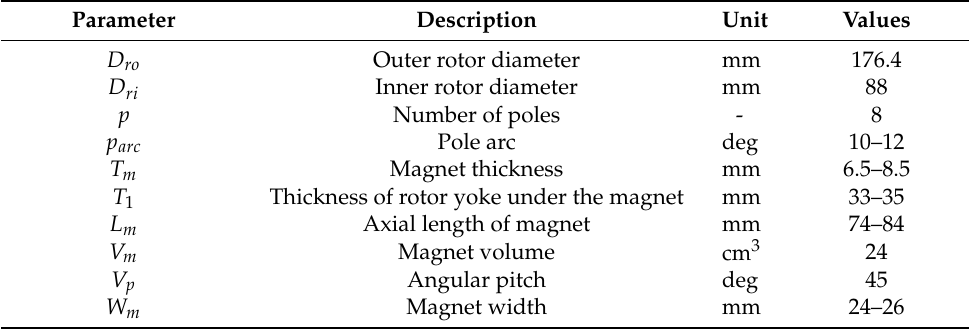
Table 2. Ranges of main rotor parameters for the considered PM